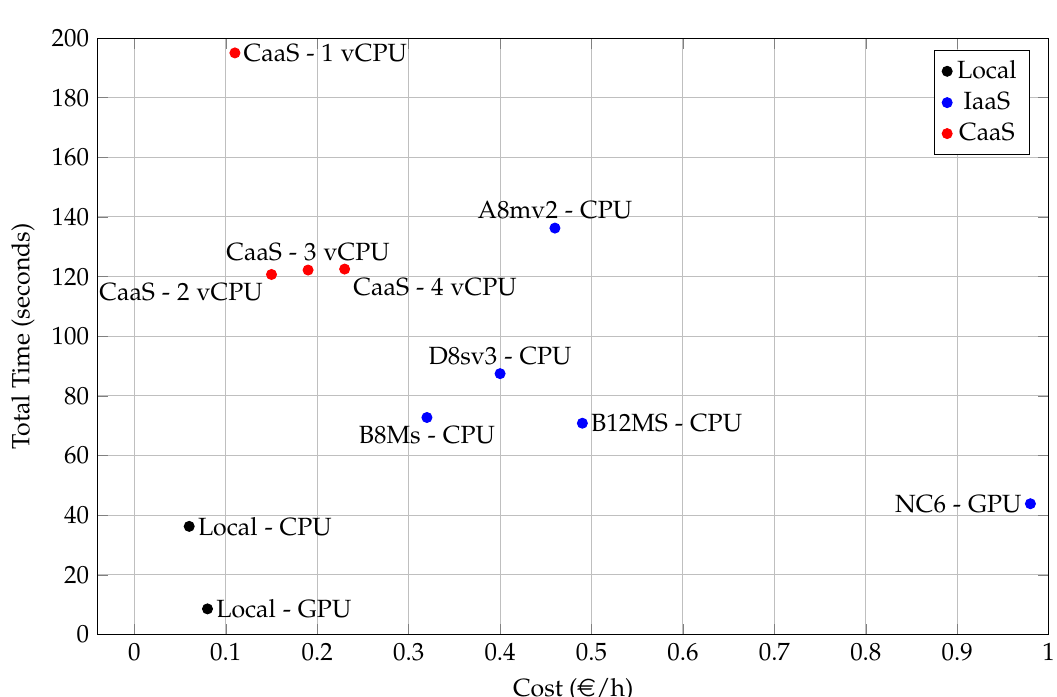
Figure 12. Performance vs. cost comparison using an image of 10,000 × 10,000 pixels. The NC12 infrastructure is not included in this chart because it performs worse than NC6 at a higher cost. NC6-CPU is not included either, as in a real case it does not make sense to pay for a GPU and not use